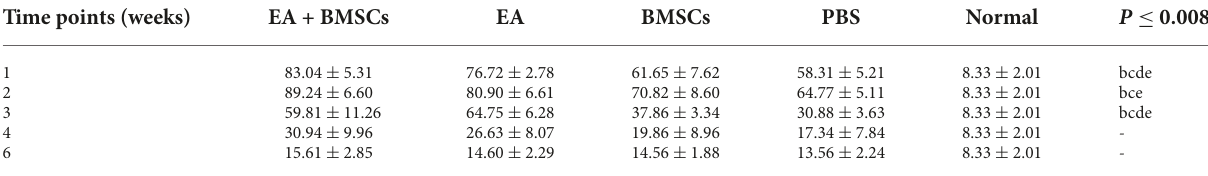
TABLE 4 IOD values in EA + BMSCs, EA, BMSCs, and PBS (mean ± SD). Time points (weeks) EA + BMSCs EA BMSCs PBS